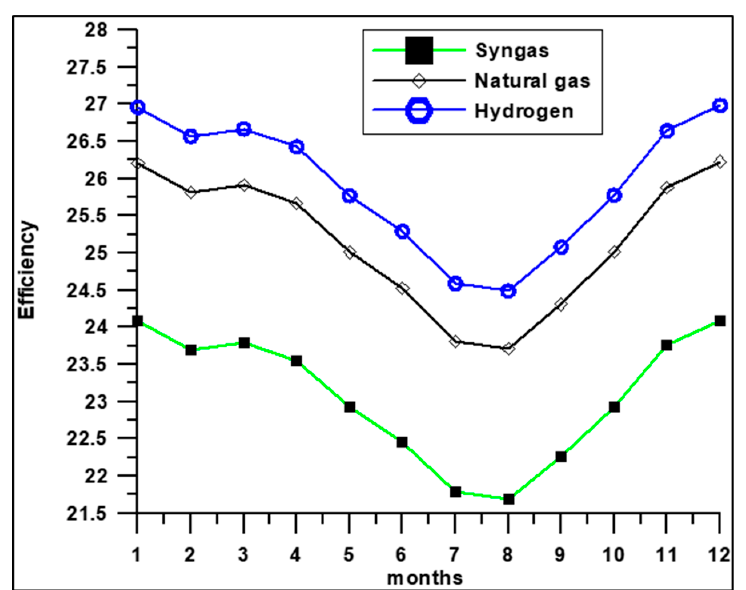
Figure 13. Thermal efficiency (LHV) in a year in diurnal hours. Energies 2020 , 13 , x FOR PEER REVIEW